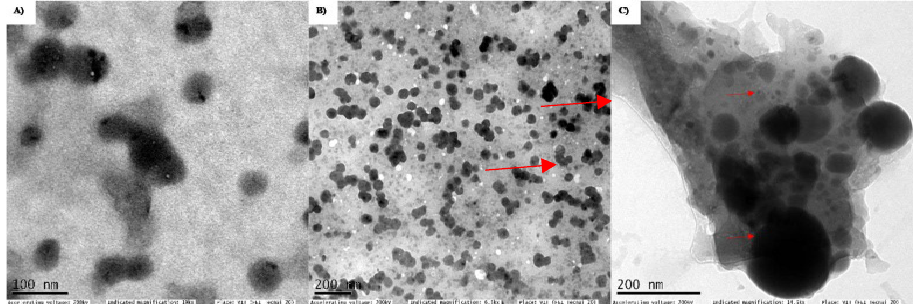
Figure 2. TEM analysis for ( A ) biosynthesized SeNPs using seed extract, ( B ) SeNPs modified with chitosan, ( C ) PTX (small rounds)-chit (covered as background)-SeNPs (larger spherical).